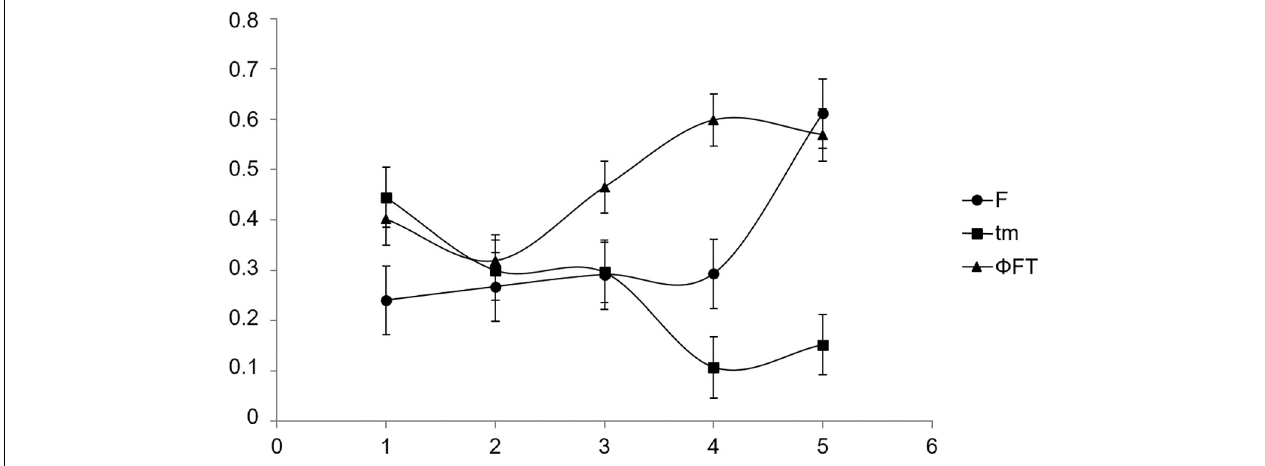
FIGURE 3 | Variation (means ± SD) in inbreeding coefficients (F; circles), outcrossing rates ( t m , squares), and pollen pool genetic structure ( (cid:56) FT , triangles), for populations from North to South of the geographic distribution of Vriesea gigantea : 1-Maquiné/2006; 2-Maquiné/2007; 3-Itapuã/2006; 4-Itapuã/2007;